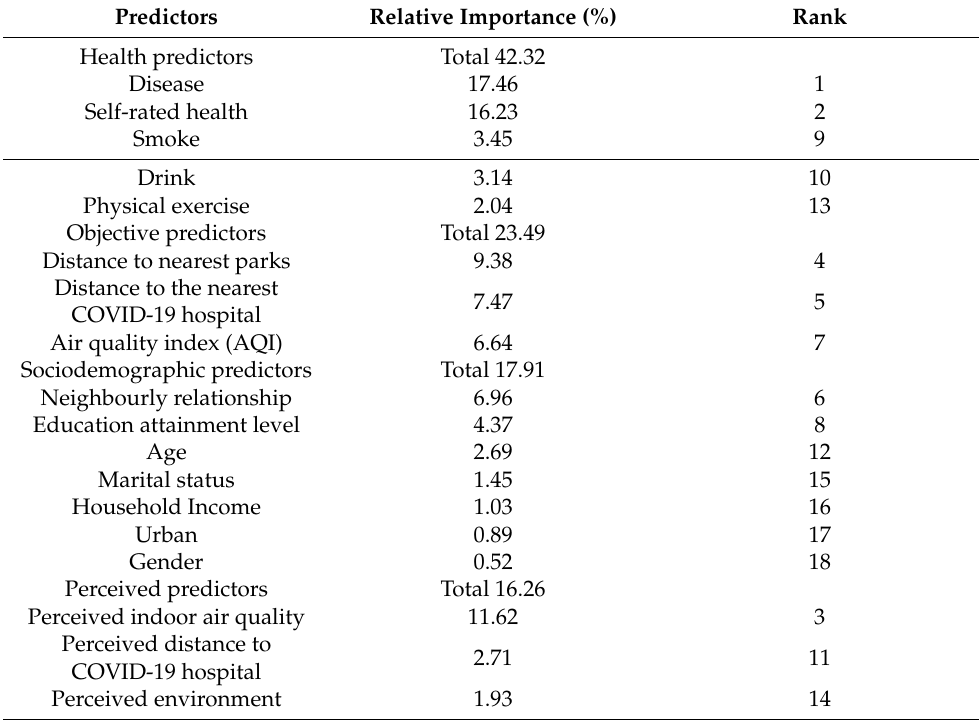
Table 2. Importance of independent variables in predicting psychological distress K6